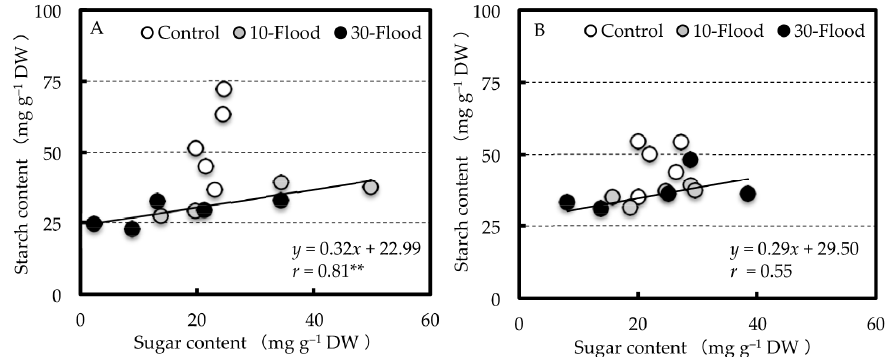
Figure 3. Effects of treatments on the relationship between starch and sugar content in the roots of grafted trees ( A ) and seedlings ( B ) of mango. Both grafted trees and seedlings show the results determined on 31 July. The regression analysis was applied to the combined data in both 10- and 30-flood treatments. ** indicates significance at p =